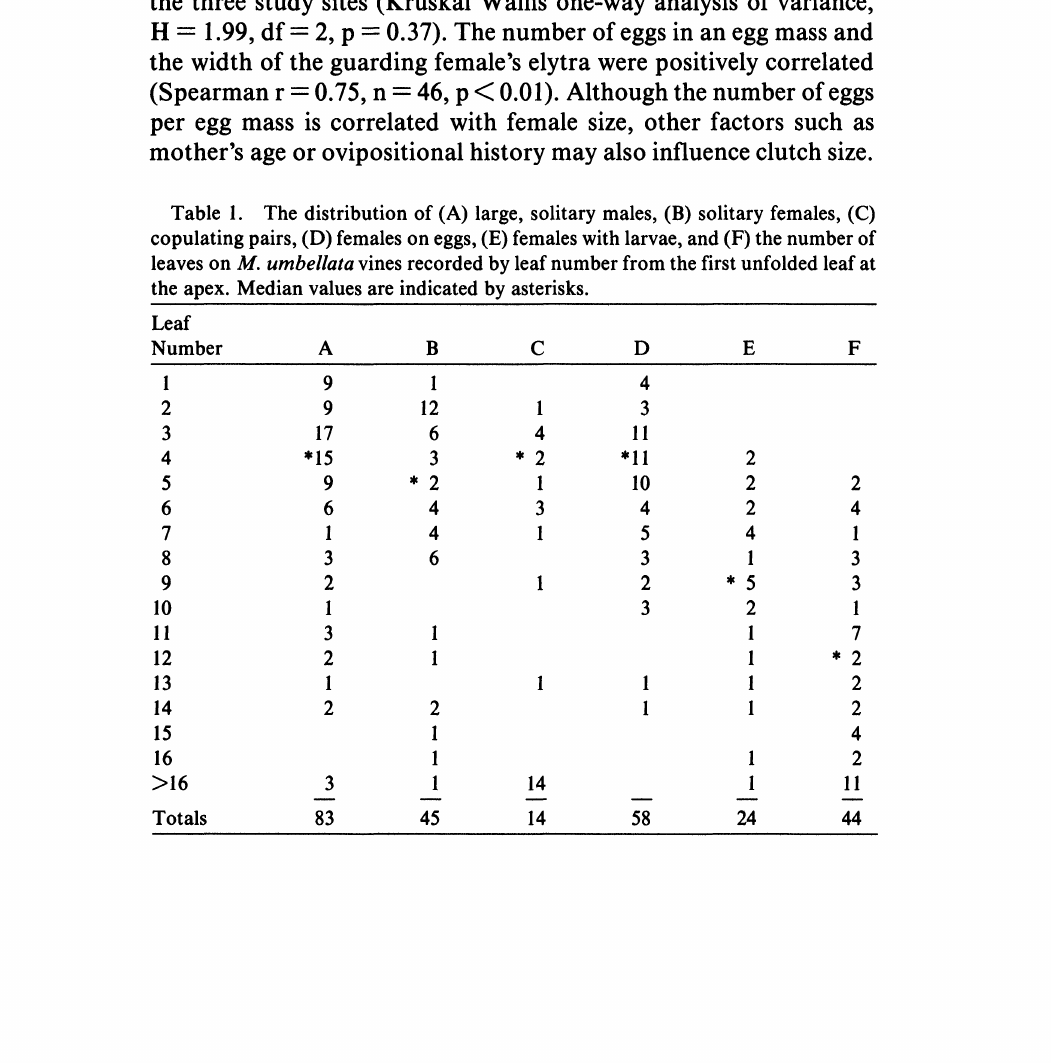
Table 1. The distribution of (A) large, solitary males, (B) solitary females, (C) copulating pairs, (D) females on eggs, (E) females with larvae, and (F) the number of leaves on M. umbellata vines recorded by leaf number from the first unfolded leaf at the apex. Median values are indicated by asterisks.